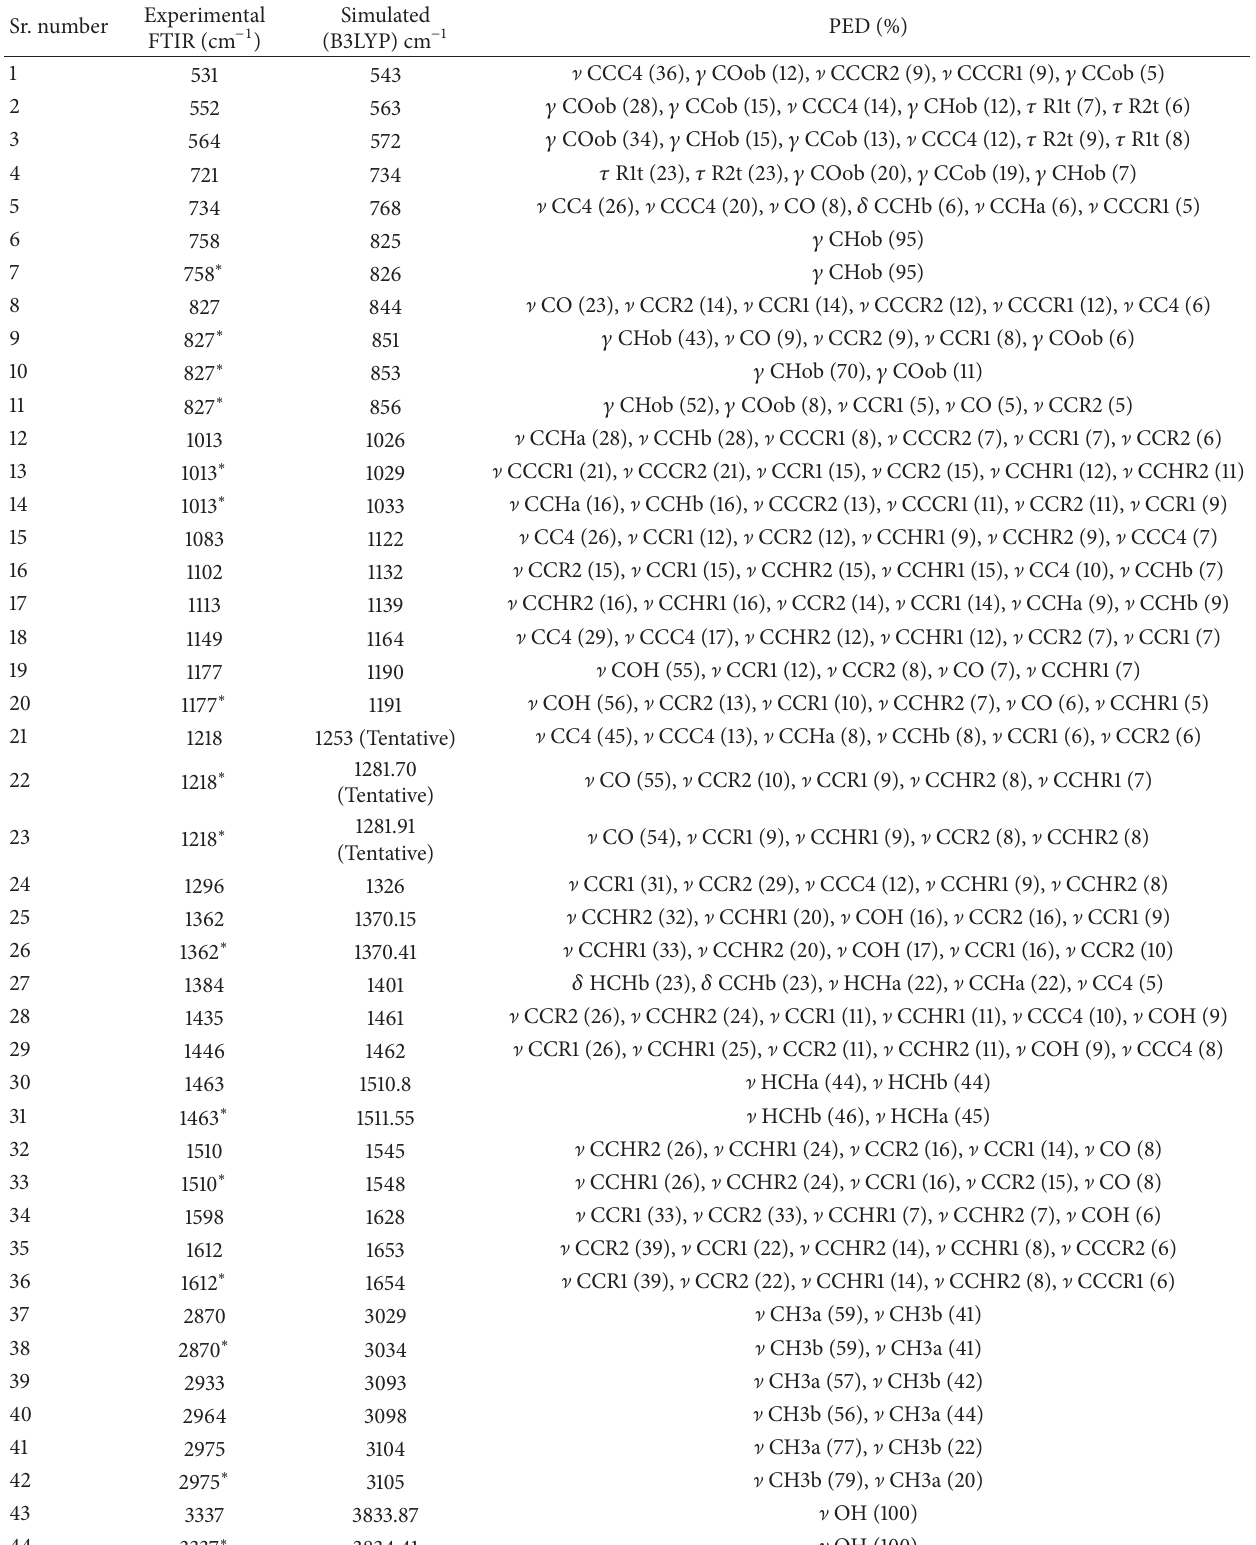
Table 1: Experimental as well as DFT absorption peaks along with PEDs. Sr.